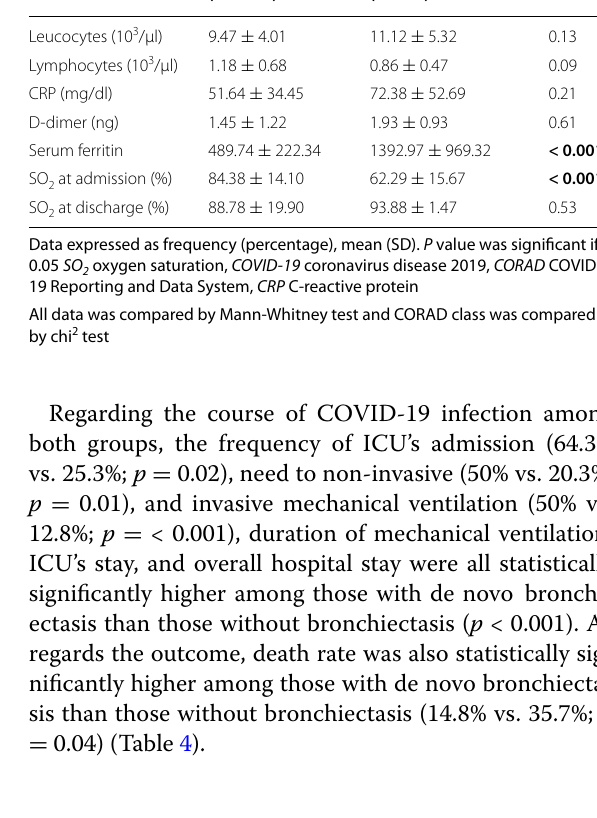
Table 3 Laboratory findings of COVID-19 patients without and with de novo bronchiectasis included in the